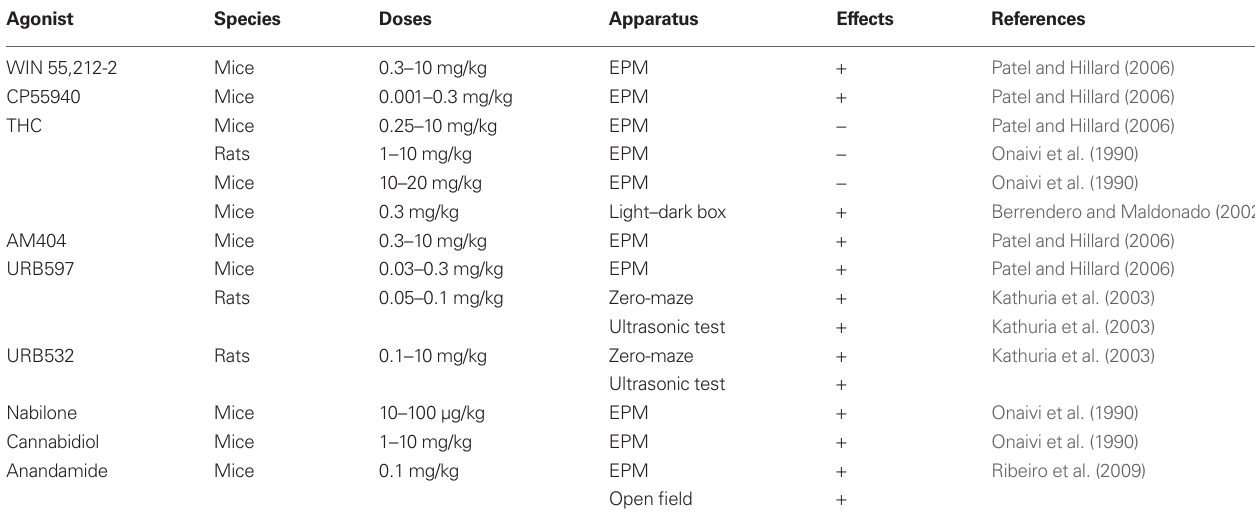
Table 2 | Effects of cannabinoids on anxiety-related responses. Agonist Species